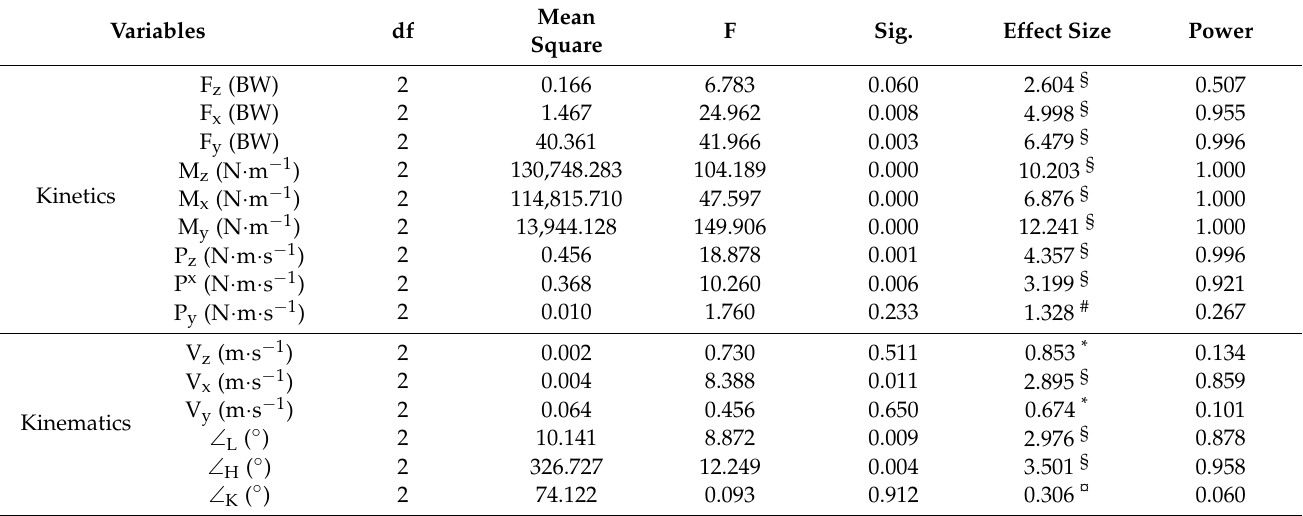
Table 2. ANOVA repeated measure between different standing back somersaults.